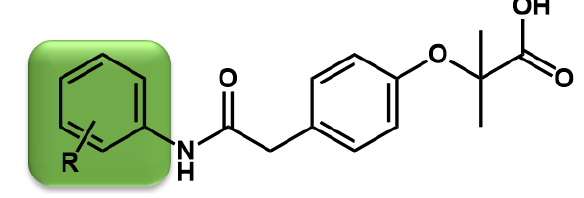
Table 1. Results of in vitro red blood cell